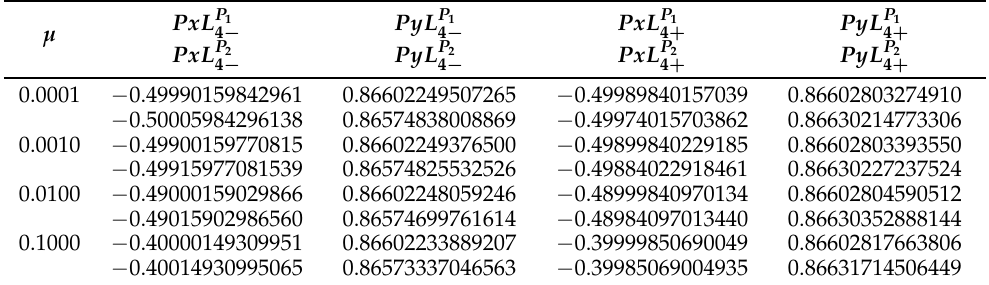
Table 7. Perpendicular equilibrium solution of the restricted 2 + 2 body problem near L 4 .